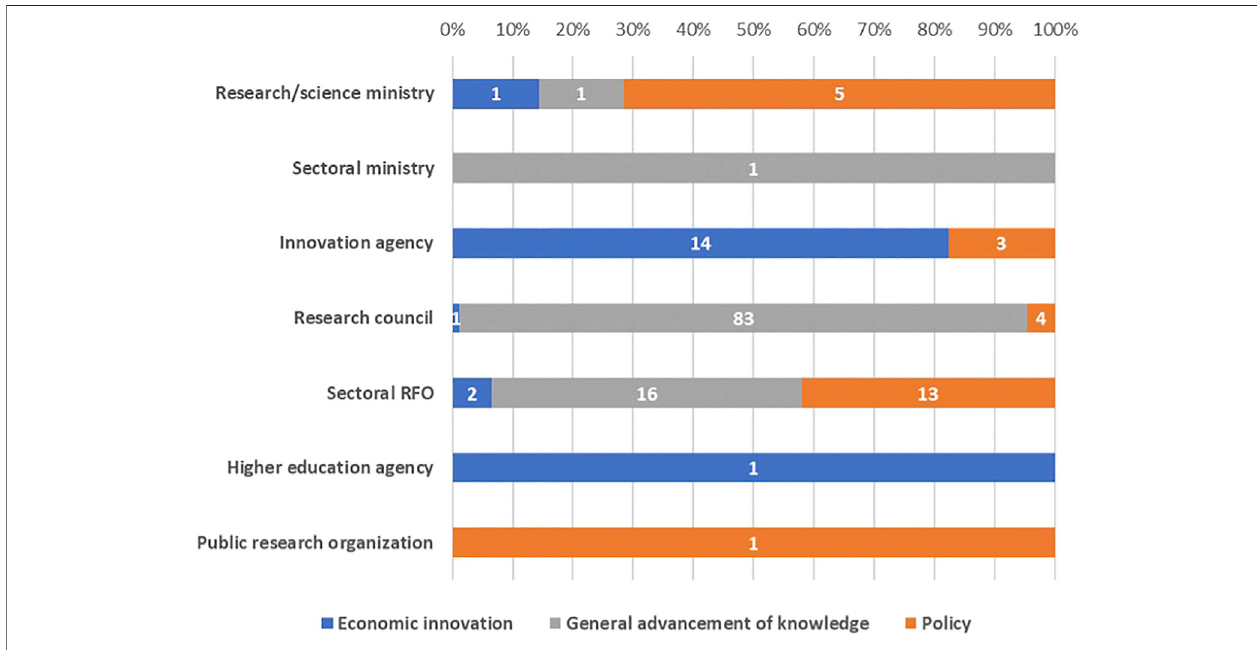
FIGURE 1 | Formal orientation of funding instrument by RFO classi fi cation (a.v. of single funding